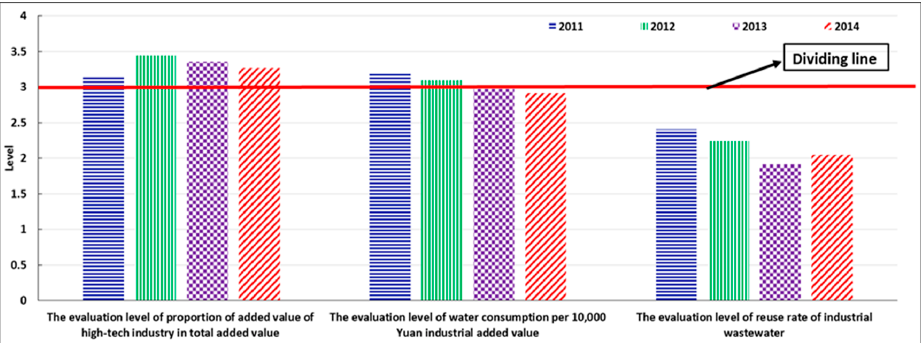
Figure 6. Industrial water usage efficiency control level in terms of its efficiency indicator parameters